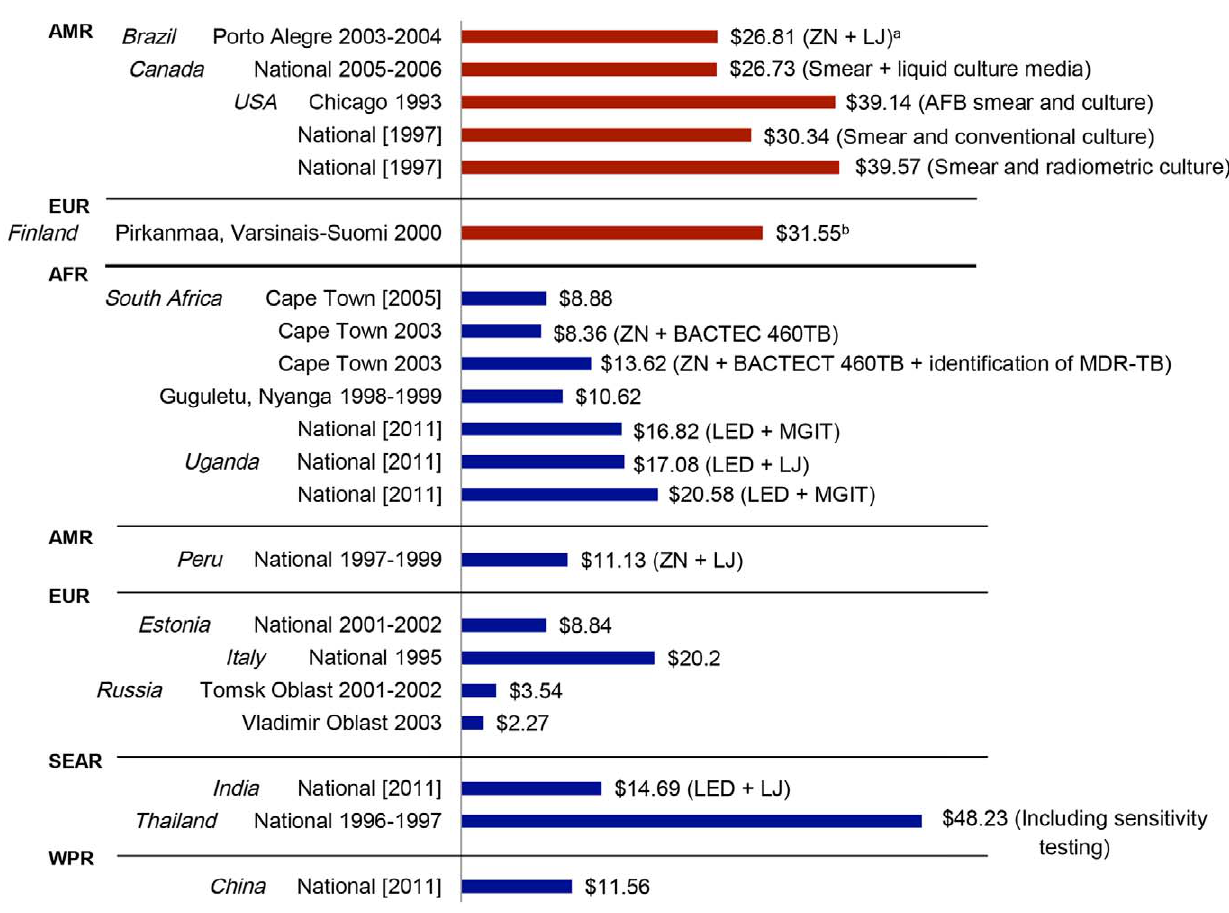
Figure 4. Unit cost in 2010 USD for combined smear and culture test. (1) Directly obtained cost data are in red; imputed cost data are in blue. (2) Cost data were sorted by WHO regions: African Region (AFR), Region of the Americas (AMR), Eastern Mediterranean Region (EMR), European Region (EUR), South-East Asia Region (SEAR) and Western Pacific Region (WPR). (3) For studies with available details on test methods, we labeled them at the end of each bar. (4) [] indicates publication year when data collection year is not available. (5) AFB: acid-fast bacillus; LJ: Lo¨wenstein- Jensen; MGIT: Mycobacteria Growth Indicator Tube. a Laboratory running cost is $ 14.34. Estimated costs incurred by patients are $ 12.47 (assuming that for taking an examination, a patient has to miss one-day work, take two-way transportation and have one meal outside). b $ 31.55 is the total cost of $ 94.66 divided by three combined smear and culture tests.